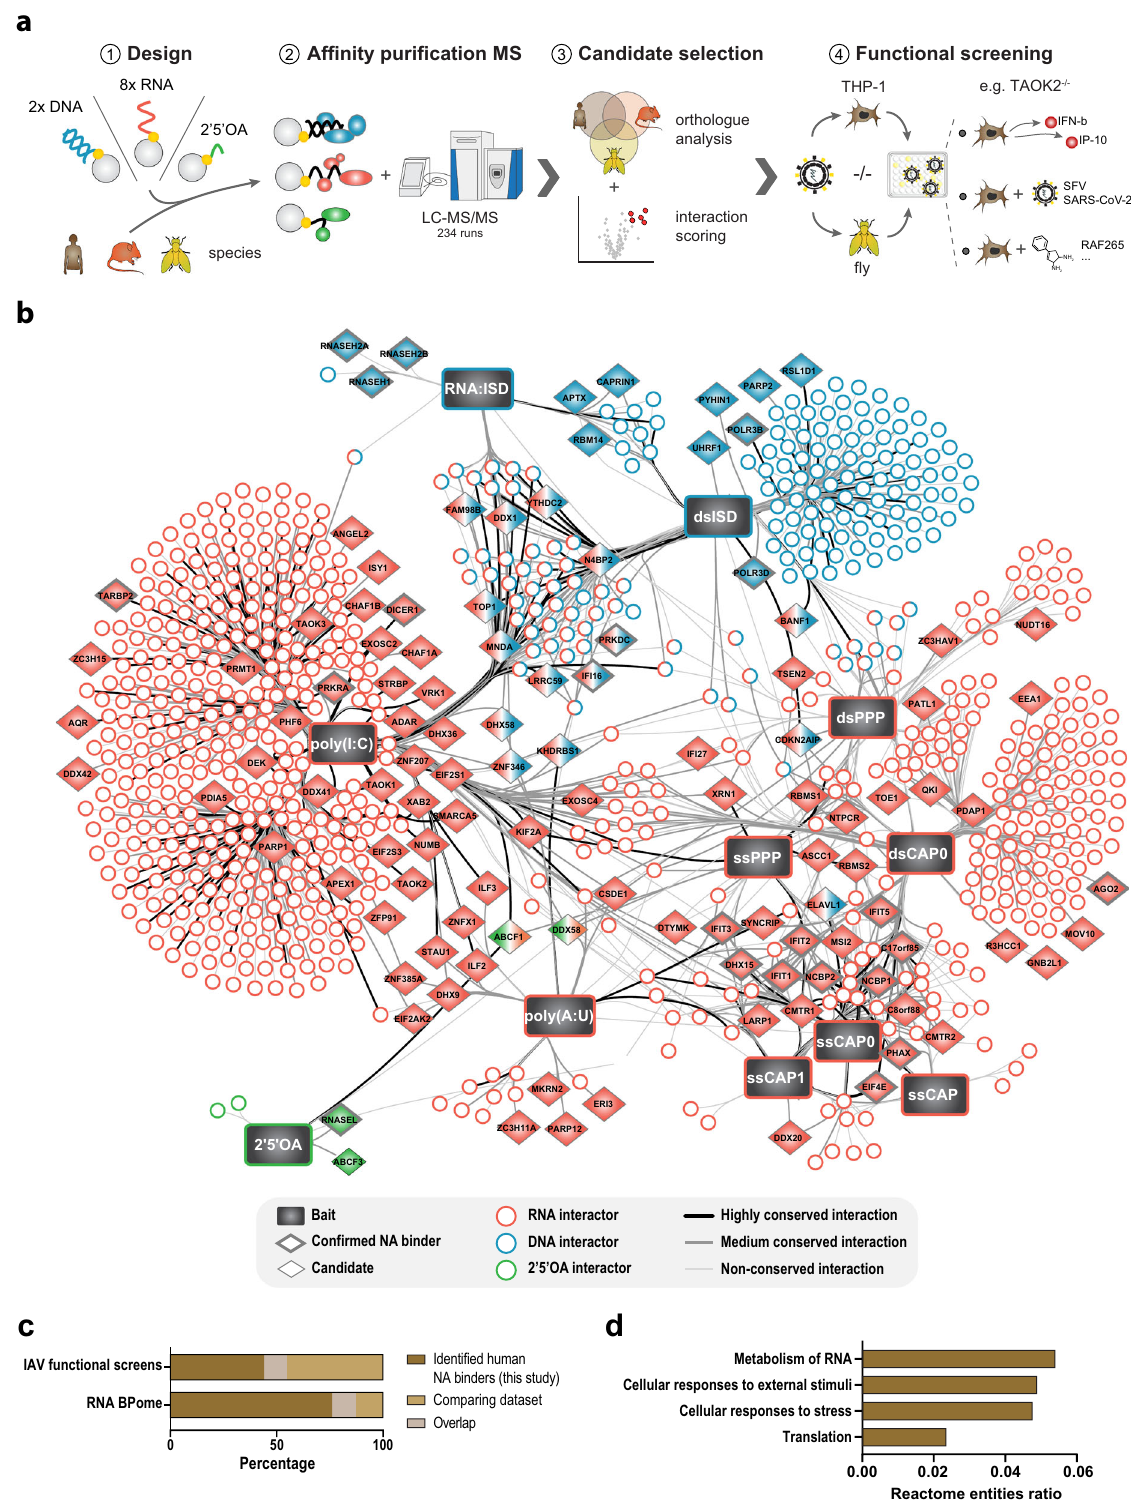
DNA (ISD) 3 , bound speci fi cally to all three ISDs; RNA:DNA hybrids recovered Ribonuclease H1, a known nuclease of RNA:DNA hybrids, as well as all three members of the ribonuclease H2 heterotrimeric complex (RNaseH2A, RNaseH2B, and RNase2C) 3 . In addition, an expected binding pattern was found for the known RNA-speci fi c PRRs RIG-I and MDA5 and proteins of the IFIT complex, which are speci fi cally